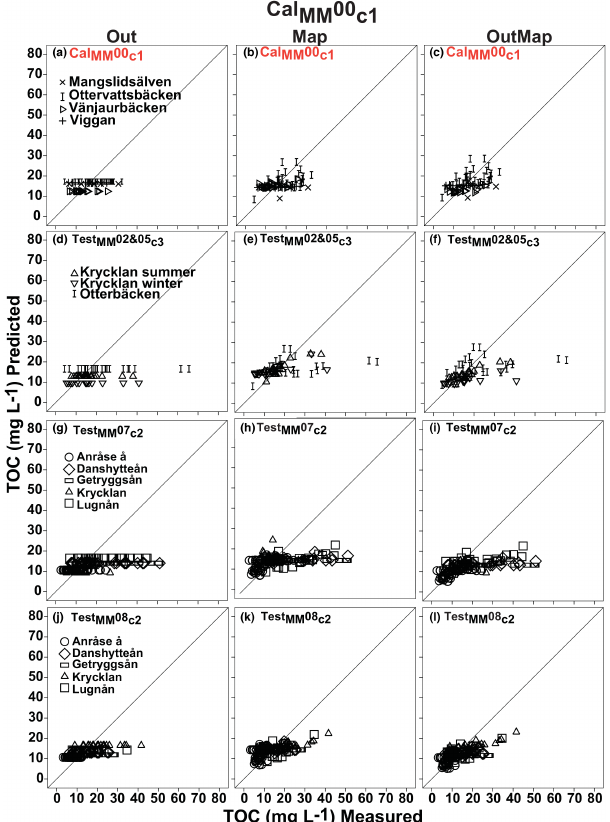
Figure 3. Scatterplots of measured headwaters with total organic carbon (TOC in mgL − 1 ) on the x axis, and the three different ver- sions of the mixed models Cal MM 00 c1 on the y axis: Out version on the left panel, OutMap version on the right panel and Map in- between. Data for year 2000 (Cal MM 00 c1 ) on the top row in red text, followed by Test data; second row 2002 & 2005 data, third row is 2007 data and the last row is 2008 data. R. Anråse å indicated by circles, R. Danshytteån by diamonds, R. Getryggsån by rectangles, R. Krycklan by triangles (winter 2005 by upside-down triangles), R. Lugnån by squares, R. Mangslidsälven by multiplication sign, R. Ottervattsbäcken by upside-down triangles, R. Vänjaurbäcken by right tilted triangles and R. Viggan by plus sign. The black line is the 1:1